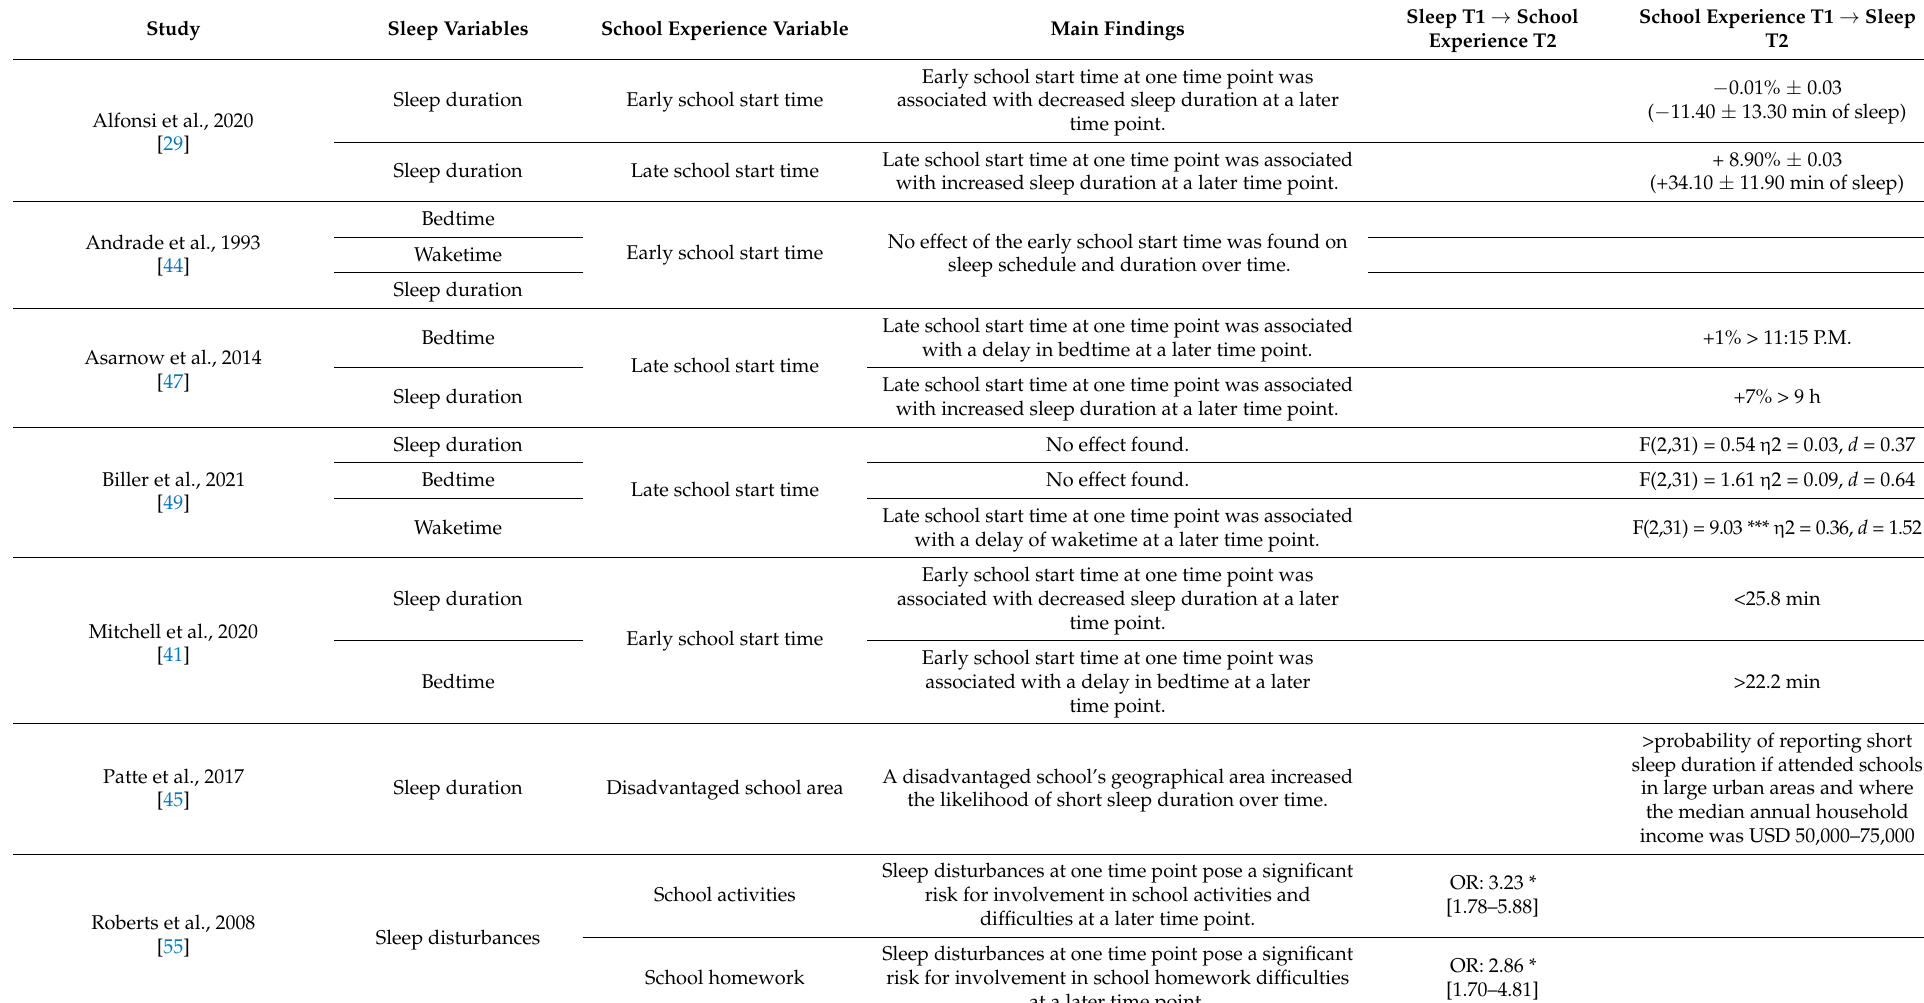
Table 5. Longitudinal association between sleep, and school structure and